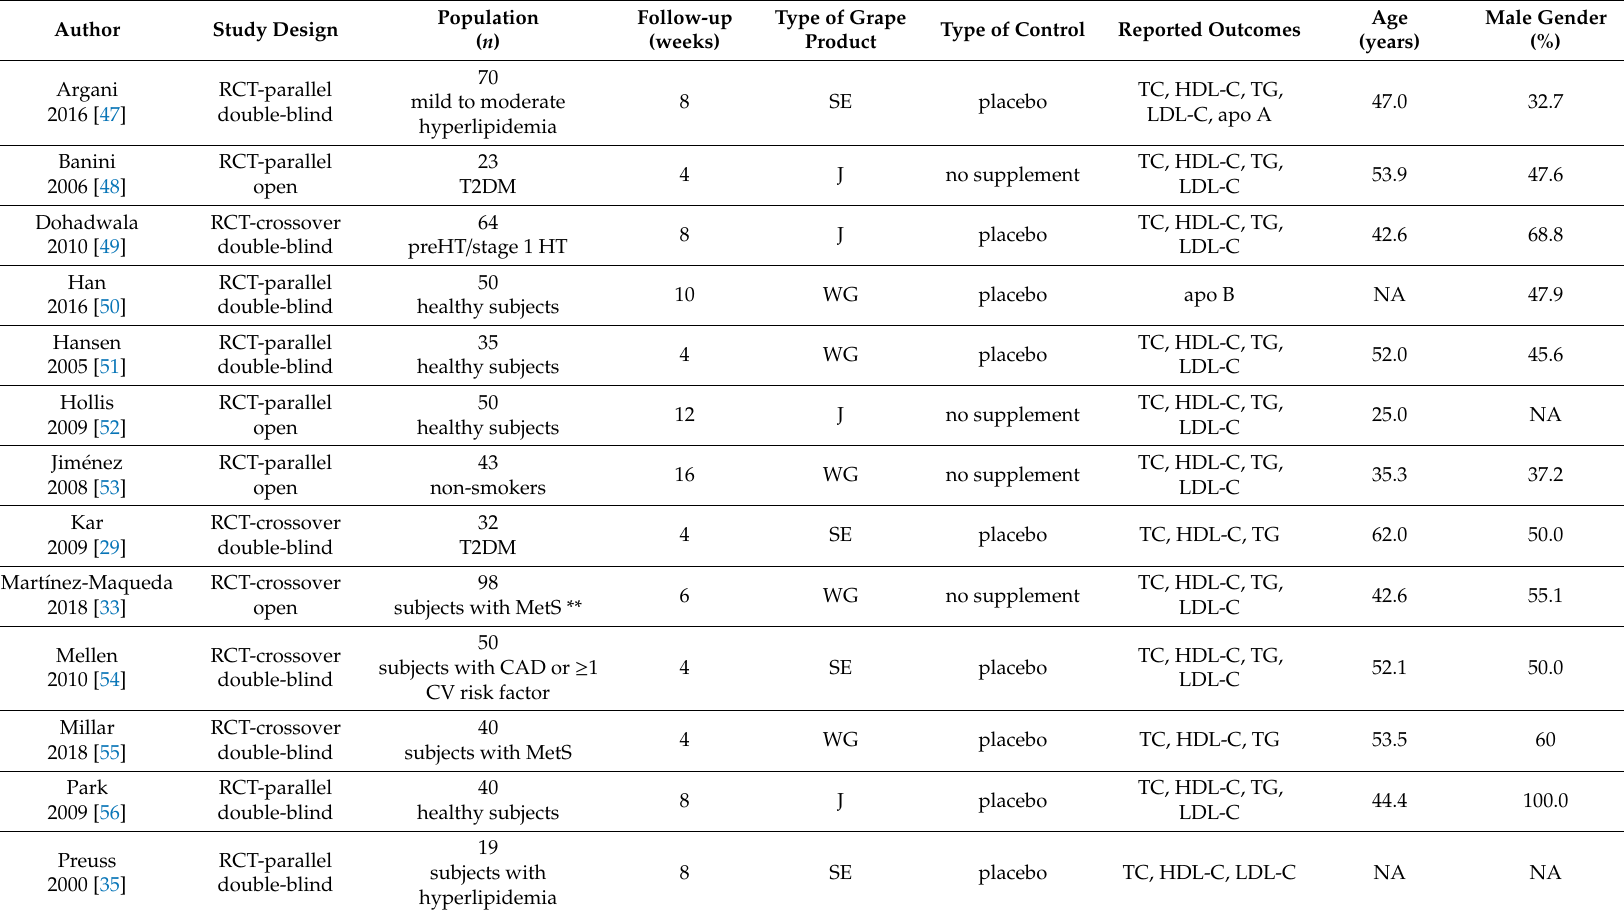
Table 1. Characteristics of included